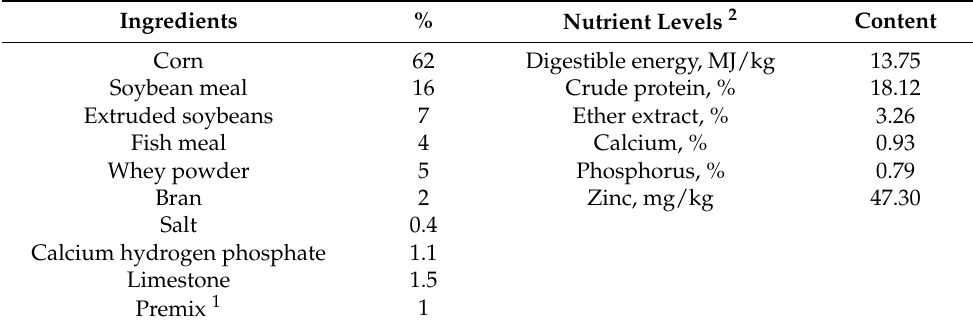
Table 1. Composition and nutrient levels of basal diet (as-fed